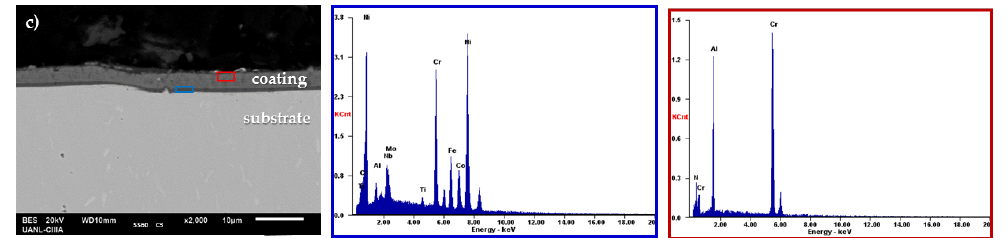
Figure 1. SEM cross-sectional micrographs of PVD coatings and its EDS: ( a ) PVD AlCrN/TiCrSiN C1, ( b ) PVD AlCrN/CrTiSiN C2 and ( c ) PVD AlCrN/AlCrN + CrN C3 coatings.